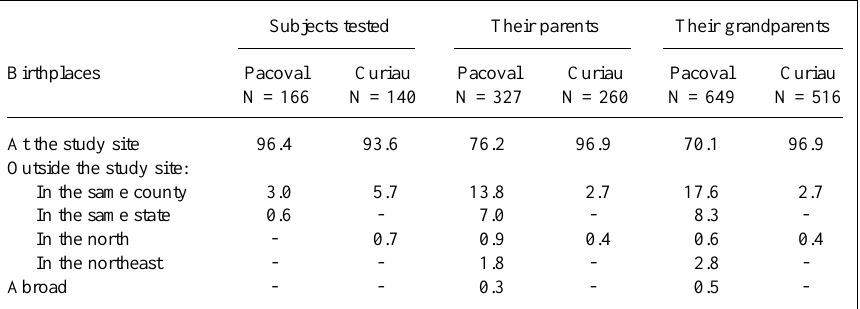
Table IV - Birthplace distribution (in %) of the individuals studied in Pacoval and Curiau and that of their ancestors. Subjects